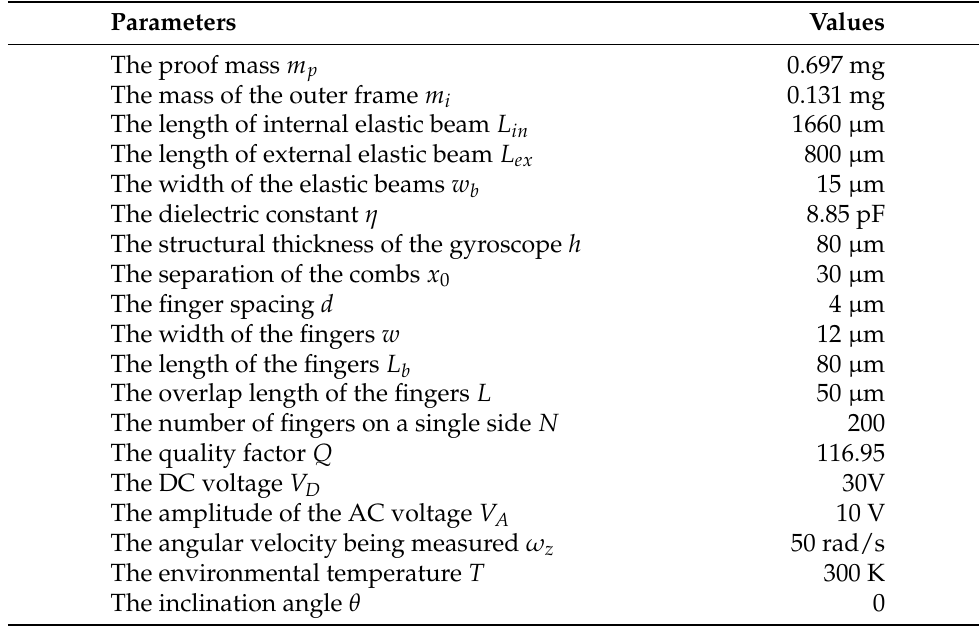
Table 1. The parameters of the MEMS gyroscope